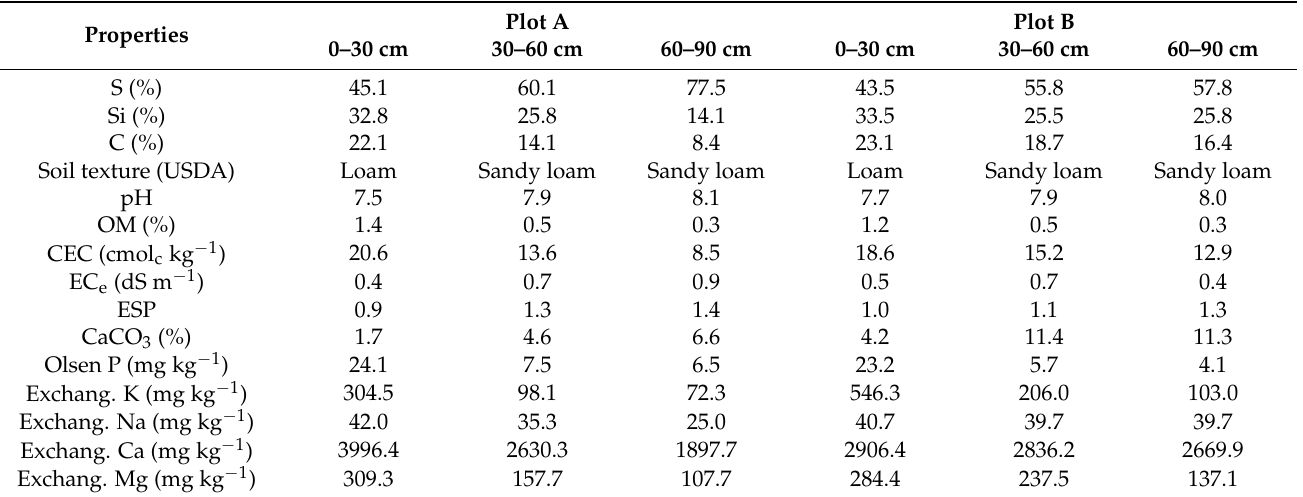
Table 2. Soil quality properties in the two plots (A and B) at the beginning of the growing season. The values shown are averages of two years (S: Sand; Si: Silt; C: Clay; OM: Organic Matter; CEC: Cation Exchange Capacity; EC e : Electrical Conductivity in the Saturation Paste Extract; ESP: Exchangeable Sodium Percentage; Exchang.: